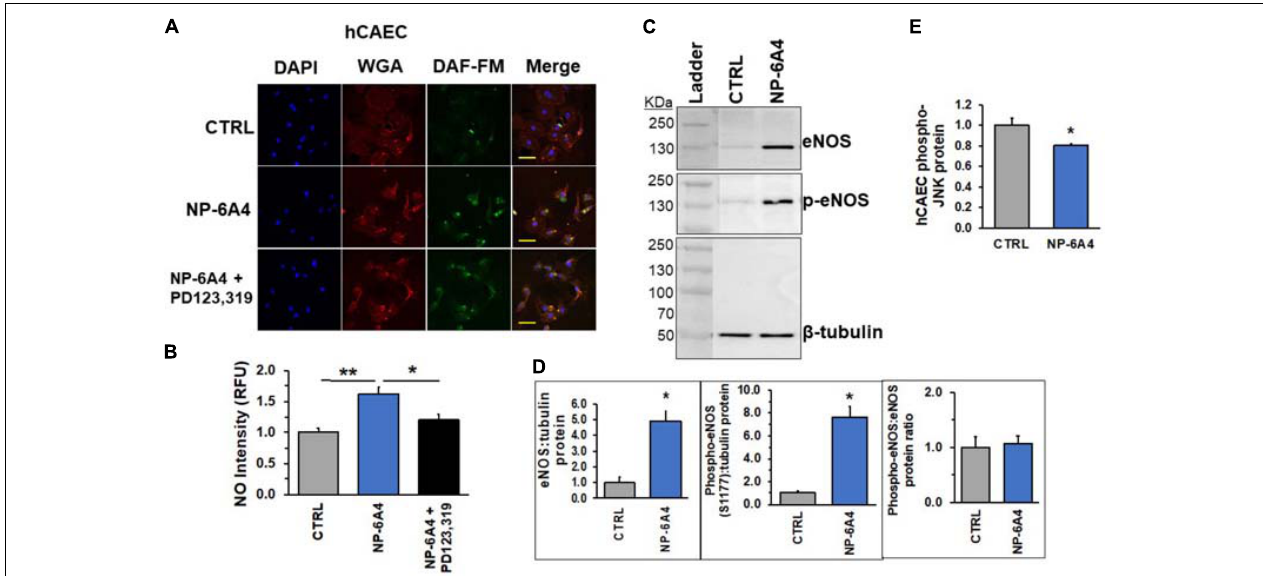
FIGURE 8 | NP-6A4 promotes cellular protective signaling in hCAECs. (A) Representative images of DAF-FM diacetate staining in hCAEC. Blue DAPI images show nuclei, Red wheat germ agglutinin (WGA) images show endothelial cell membrane, Green DAF-FM images show presence of detectable nitric oxide, and lastly, merged images show al three colors on one image. n = 3. (B) Quantification of detectable NO showed that 5 µ M NP-6A4 for 24 h increased NO, while PD123319 pretreatment prevented the increase. Fluorescent staining experiments consisted of quantification of > 50 cells from triplicates. (C) Representative western blot images of eNOS and phospho-eNOS protein. (D) Quantification of eNOS and phosphos-eNOS show increased expression of eNOS after 12-h of 1 µ M NP-6A4 treatment. The total to phospho-eNOS ratio was not affected. n = 4. (E) 5 µ M NP-6A4 of hCAEC for 24-h decreased phosphorylated-JNK as determined by the Milliplex MAP Multi-Pathway Total and Phospho- Magnetic Bead 9-Plex Assay. ∗∗ Indicates difference from CTRL and ∗ Indicates difference from NP-6A4-treated at p < 0.05 using One-way ANOVA. Yellow scale bar = 100 microns. hCAEC, human coronary artery endothelial cell; DAF-FM = 4-Amino-5-Methylamino-2 (cid:48) ,7 (cid:48) - Difluorofluorescein